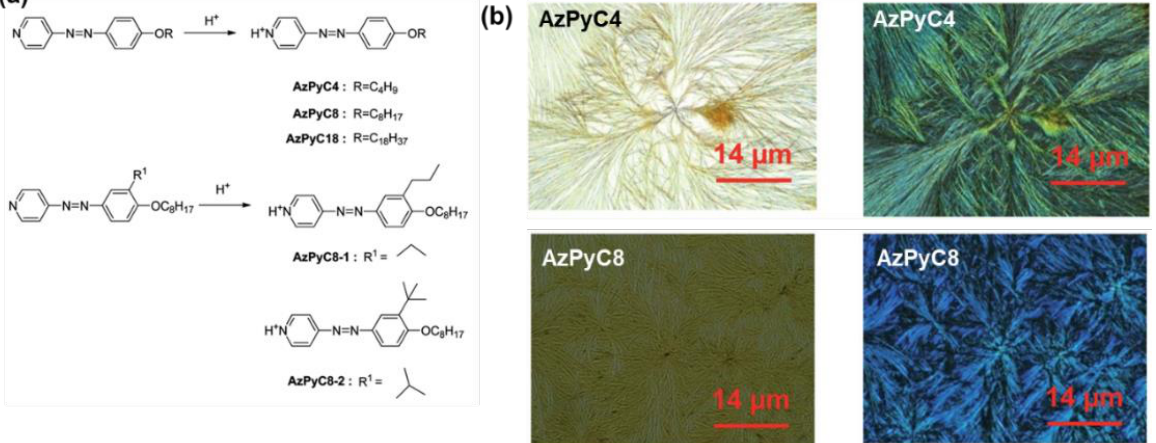
Figure 23. ( a ) Structure and synthesis of low-molecular-weight compounds for fabrication of organic nanofibers. ( b ) Optical images and POM images of AzPyC4 and AzPyC8. Reprinted with permission from [121]. Copyright 2015, Royal Society of Chemistry.